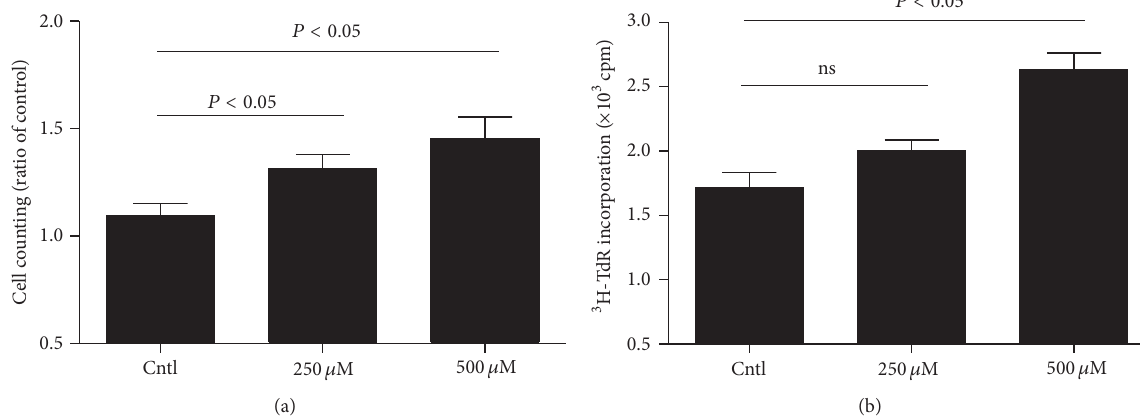
Figure 1: Effect of indoxyl sulfate (IS) on cell proliferation in MCs. After mesangial cells were cultivated to 60%–70% confluence, they were treated with IS for 24 h at different doses (0, 250, and 500 𝜇 M) and cell proliferation was measured by cell counting (a) and [ 3 H] thymidine ( 3 H-TdR) incorporation (b). Values are means ± SD; 𝑛 = 6 in each group.